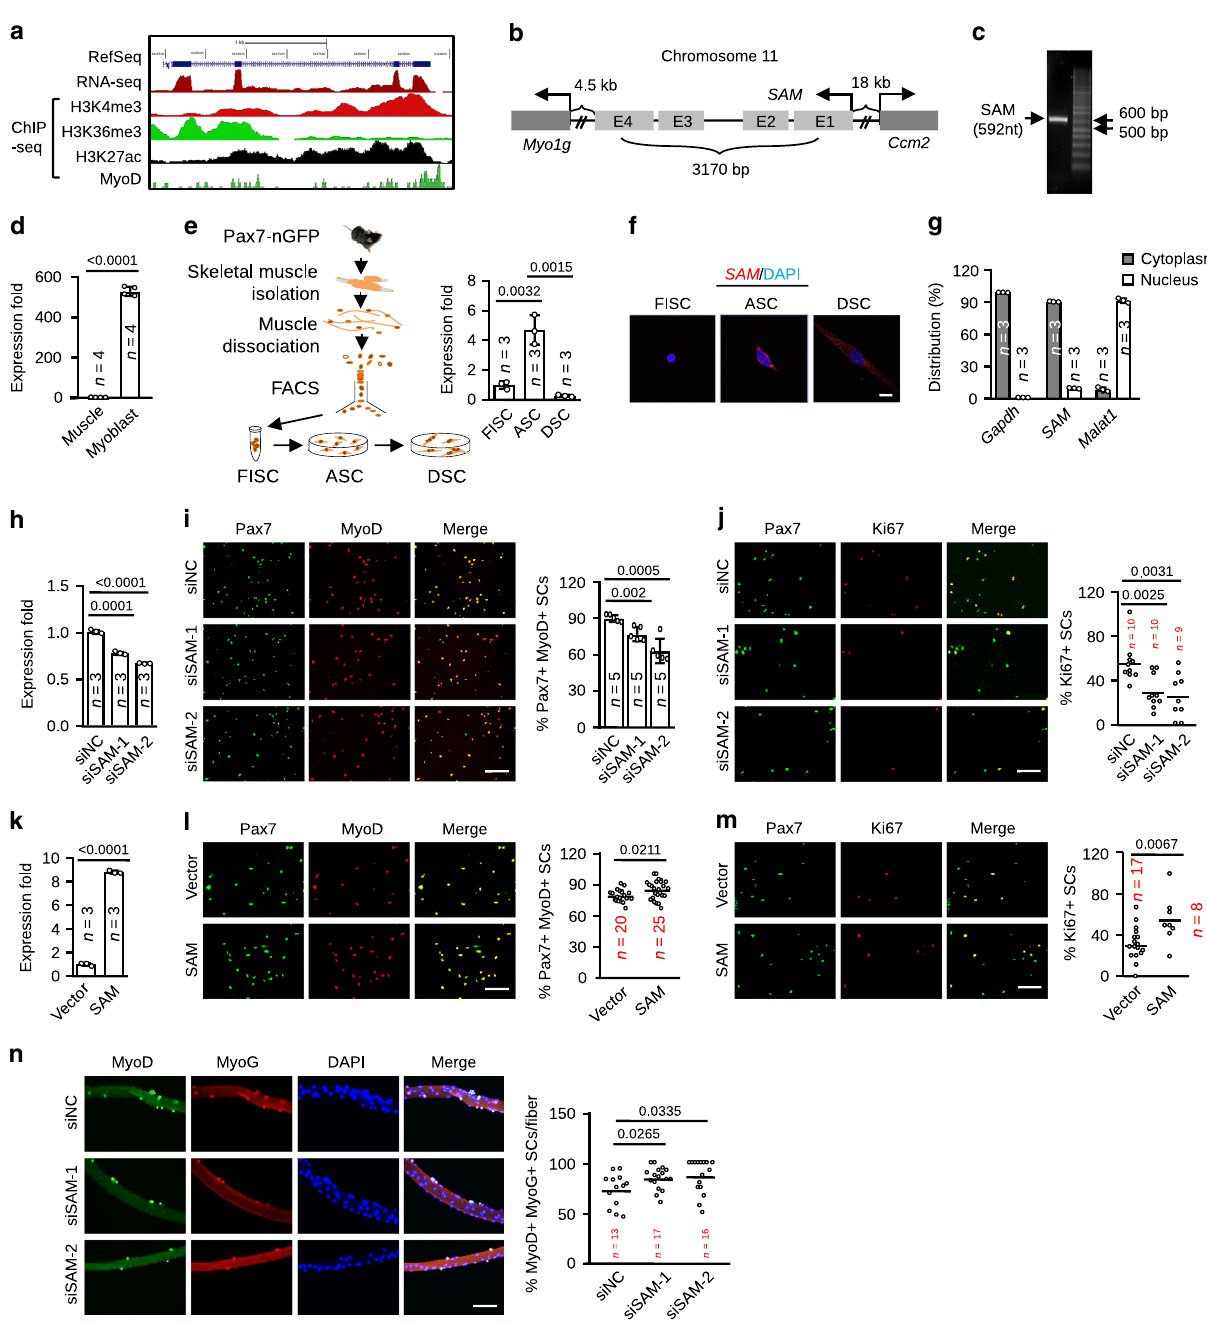
Fig. 1 SAM is enriched in myoblast and promotes cell proliferation in vitro. a Genomic snapshot of mouse SAM generated in RefSeq, RNA-seq, histone marks ChIP-seq from activated satellite cells (ASCs), MyoD ChIP-seq from C2C12 myoblasts. b Schematic illustration of the genomic location and structure of mouse SAM ( Gm11974 ) locus. c Semi-quantitative RT-PCR detection of full-length SAM transcript (592 nt) in C2C12 myoblasts. d qRT-PCR analysis of SAM in mouse muscle vs. isolated primary myoblasts. e qRT-PCR detection of SAM in freshly isolated SCs (FISCs), activated SCs (ASCs), or differentiated SCs (DSCs) isolated from muscles of Tg: Pax7-nGFP mice. f FISH was performed in the above FISCs, ASCs, or DSCs. g qRT-PCR analysis of RNAs puri fi ed from cytoplasmic or nuclear fraction of ASCs. h qRT-PCR detection of SAM from ASCs transfected for 48 h with either control (siNC) or SAM siRNA (si SAM -1 or si SAM -2). i Immuno fl uorescence (IF) staining for Pax7 and MyoD or j Ki67 was performed in the above transfected cells and the percentage of positively stained cells was quanti fi ed. k qRT-PCR detection of SAM from ASCs transfected for 48 h with a Vector or SAM expressing plasmid. l IF staining for Pax7 and MyoD or m Ki67 was performed in the above transfected cells. n Single myo fi bers were isolated from EDL muscles of adult C57BL/6 mouse and transfected with si SAM oligos. IF staining of MyoD and MyoG was performed 72 h after transfection and the percentage of positively stained cells was quanti fi ed. The data are presented as mean ± SD in d , e , g – i and k . The center line in j , l , m , and n is presented as mean. The p values by two-tailed unpaired t test are indicated in d , e , h – n . The total number of biologically independent samples are indicated in d , e , g – n . Scale bars: 10 µ m f , 100 µ m i , j , l , m , and n . Source data are provided as a Source Data fi